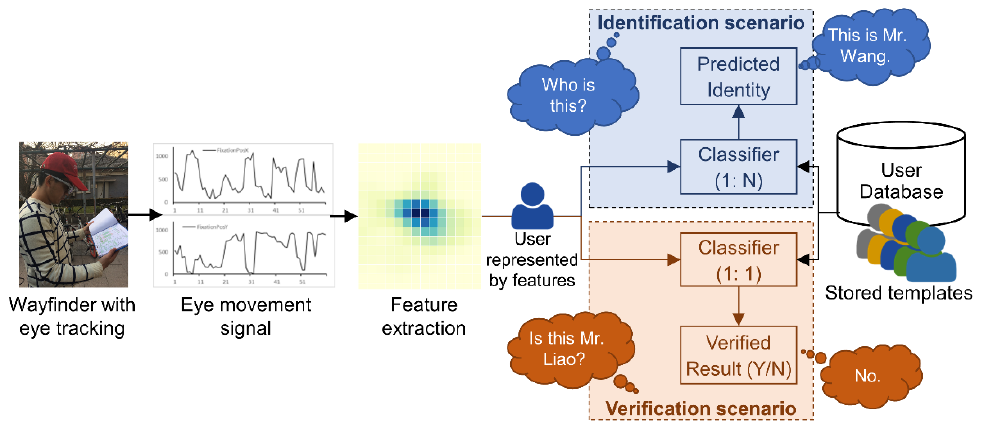
Figure 5. The framework of user identification and verification.